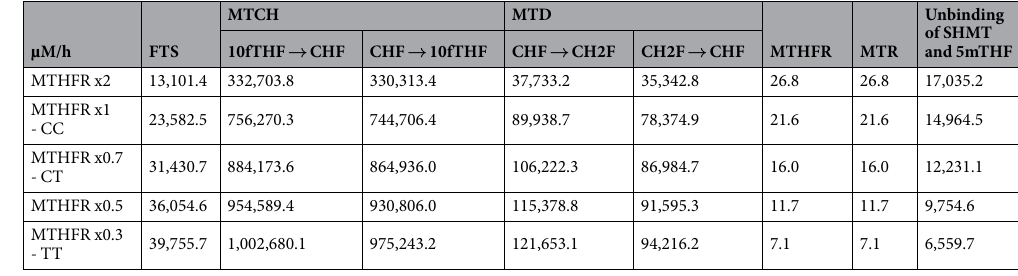
Table 3. Fluxes of the reactions catalyzed by the enzymes FTS, MTCH, MTD, MTHFR and MTR and the binding of 5mTHF and SHMT for different levels of MTHFR activity (ranging from 2x to 0.3x of wild type). CC, CT and TT refer to the C667T